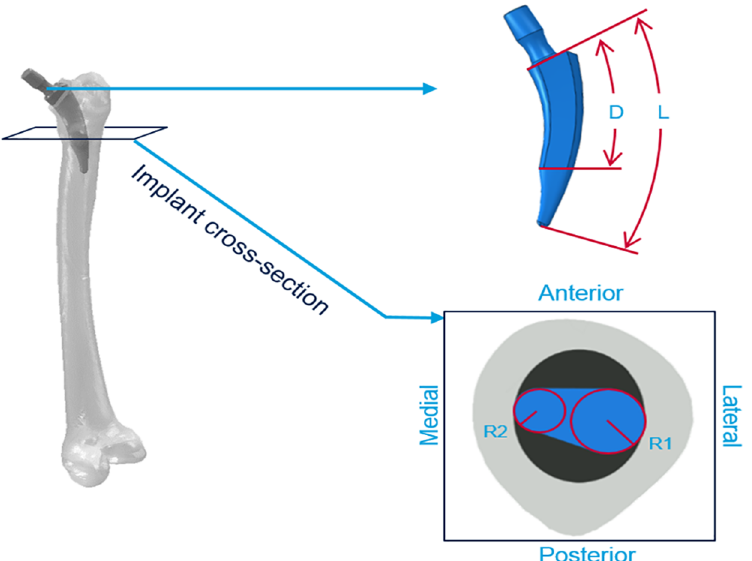
Fig 1. Graphic representation of the four considered parameters. L: total stem length, measuredfrom the implantneck to the distal tip. D: relativedistancebetweenthe neck and the cross section that separates the part of the stem which is directly in contact with the cortical bone and the part that is not in contact. R1: radius of the circumference in the lateral side of the cross section. R2: radius of the circumference in the medial side of the cross